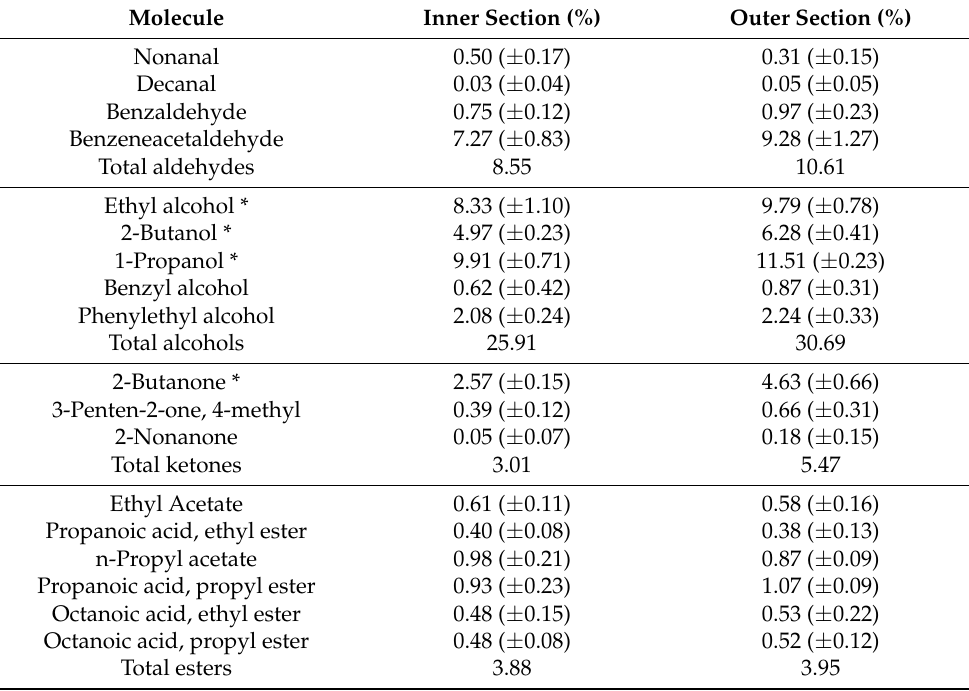
Table 4. Aroma profile of sausages detected by SPME-GC-MS in the ripened sausages in the inner and in the outer section. Data are expressed as percentage of the ratio between peak area of each molecule and peak area of the internal standard (4-methyl-2-pentanol). Results are the mean of three independent repetitions and standard deviations are reported in brackets. For each molecule significant differences between samples according to Mann-Whitney test are indicated by the presence of an